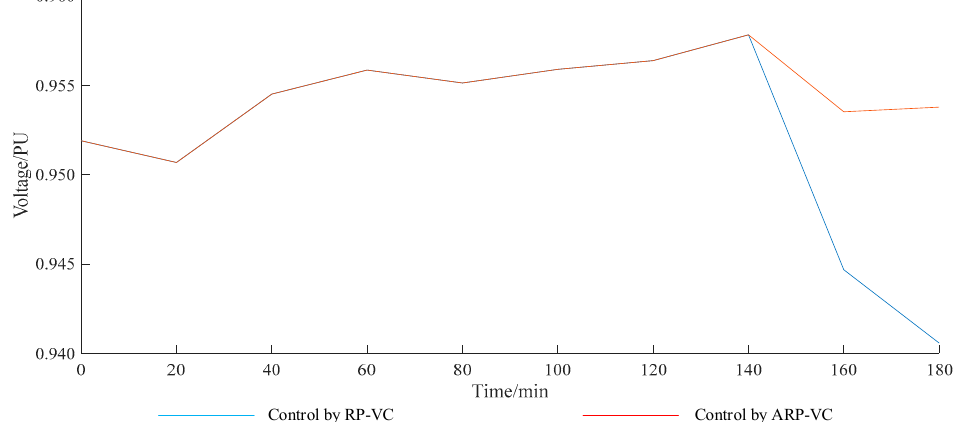
Figure 9. Voltage of bus 31 when active and reactive power coordination (ARP-VC) or reactive power balance (RP-VC) is used for control.